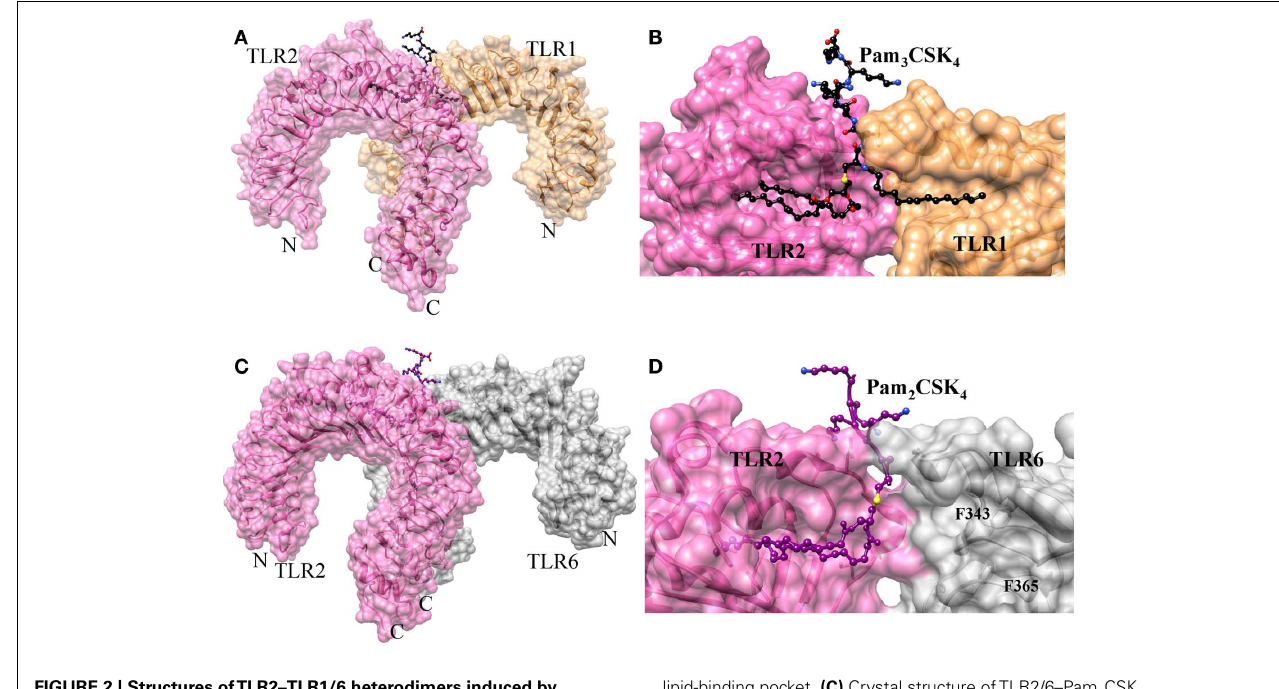
lipid-binding pocket. (C) Crystal structure ofTLR2/6–Pam 2 CSK 4 complex.TLR2,TLR6, and Pam 2 CSK 4 are colored in hot pink, gray, and deep magenta, respectively. (D) Lipid-binding pocket in